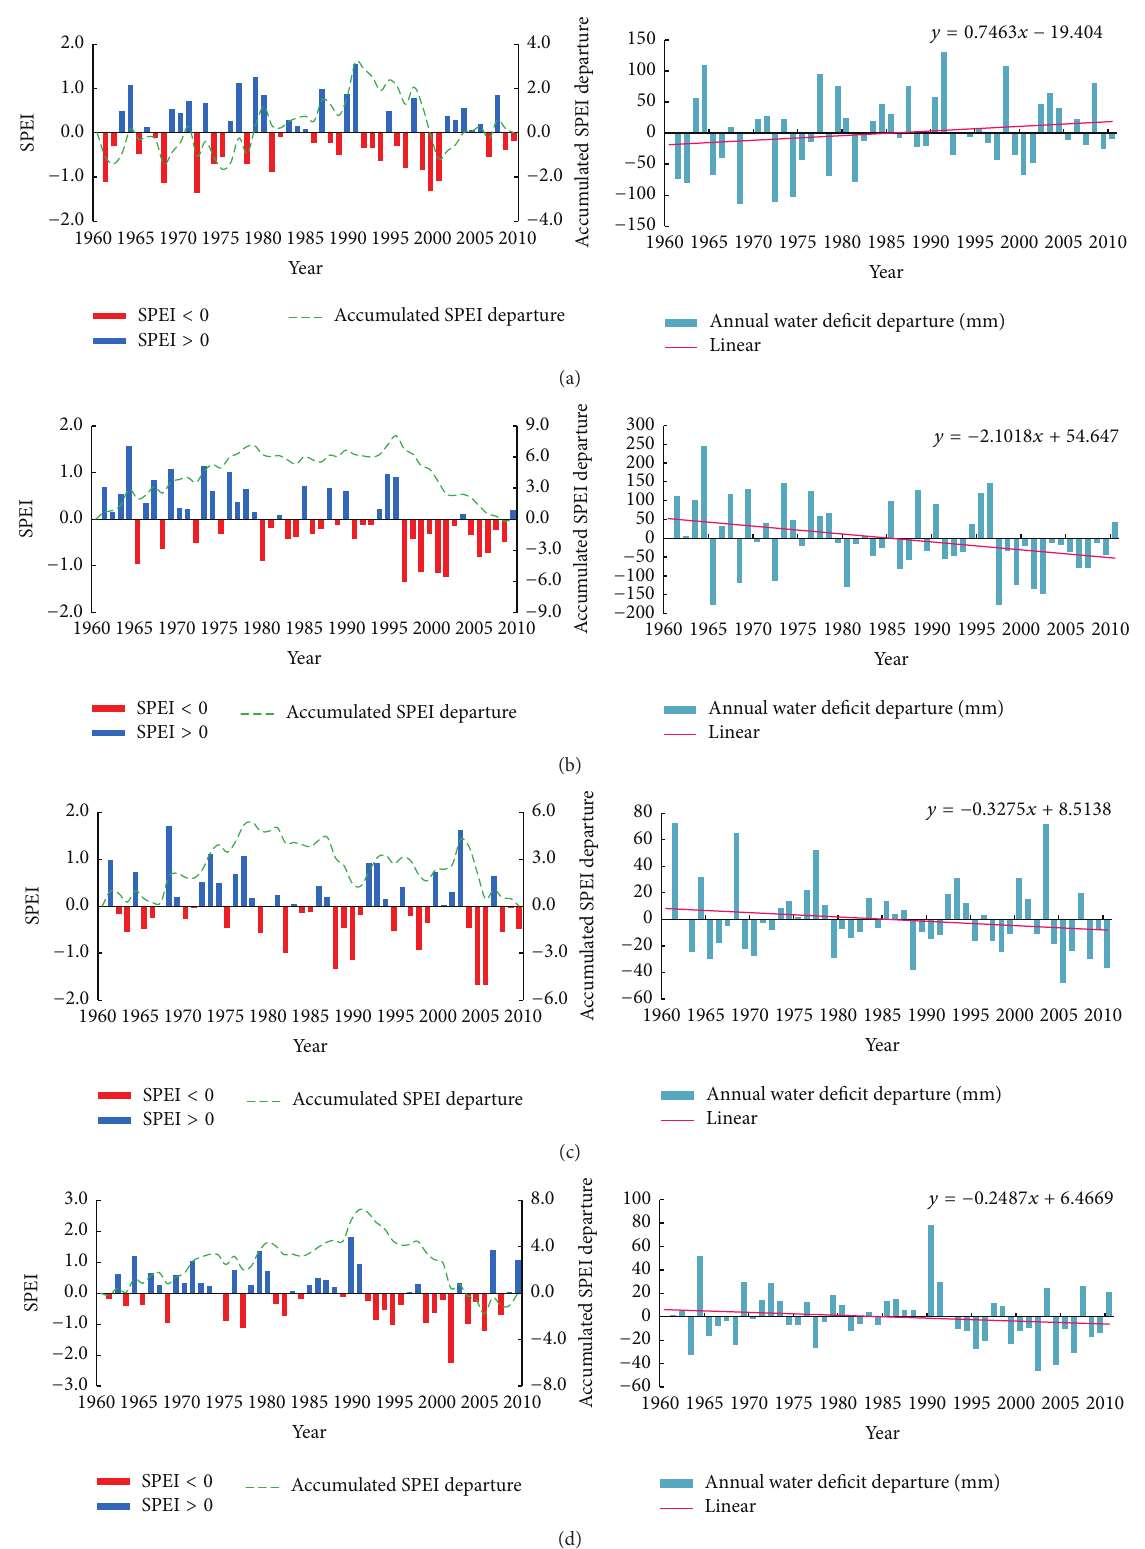
Figure 3: The interannual variability of (a) spring, (b) summer, (c) autumn, and (d) winter SPEI value (left) and water deficit